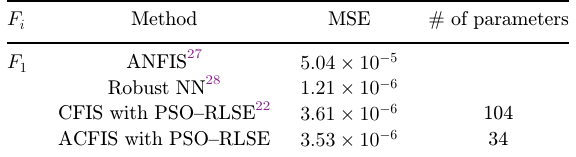
Table 4. Performance comparison in experiment (testing phase).